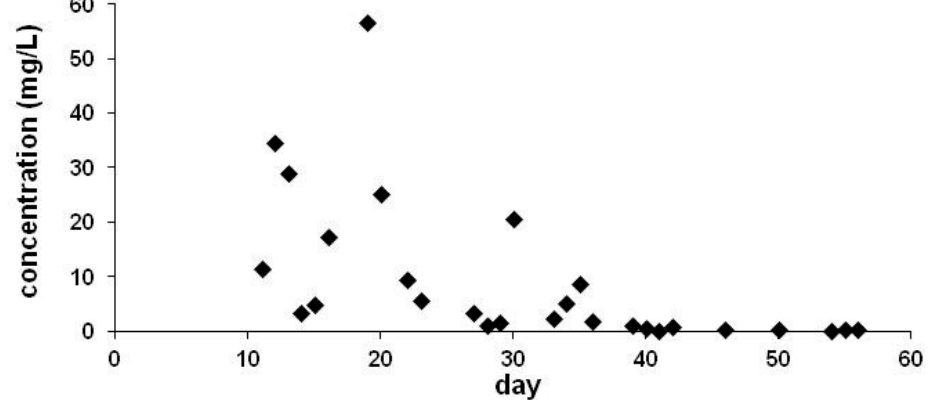
Figure 2. Concentration in the guttation liquid of maize plants emerged from coated seeds (0.997 mg CLO/seed) under field conditions.